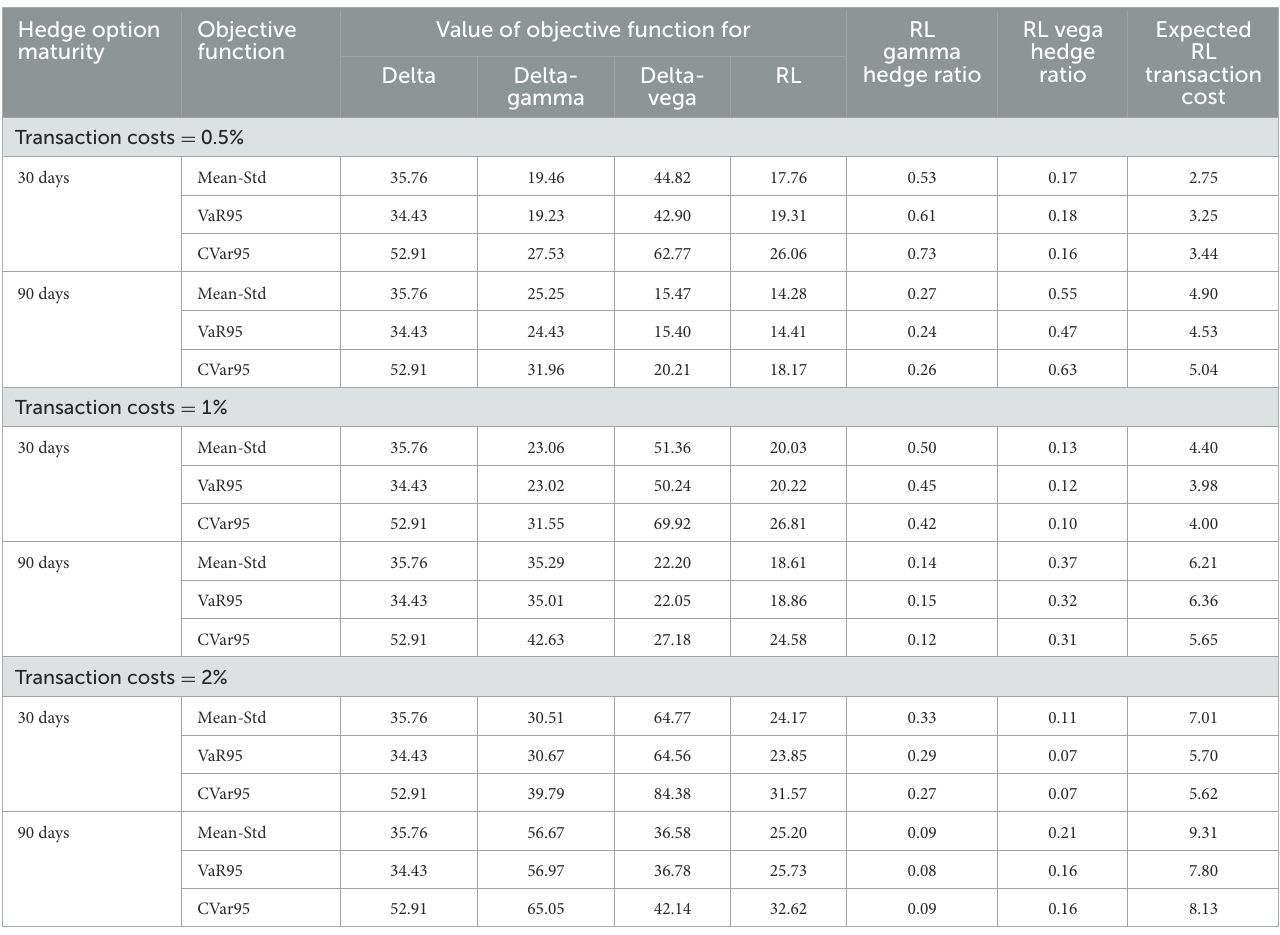
TABLE 3 Results of tests when volatility is stochastic. Hedge option maturity